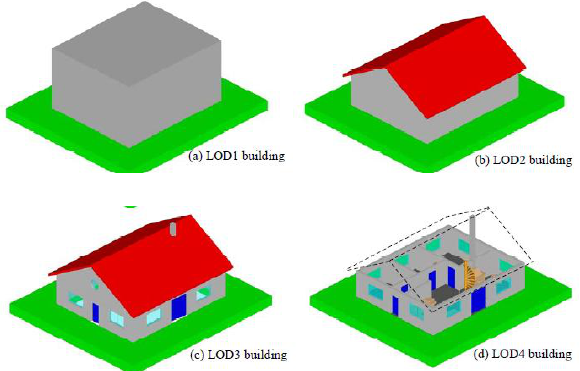
Figure 1. Examples of structured geometric models (Gröger et al. , 2007) along with rich semantics at different LoDs (LoD1 –